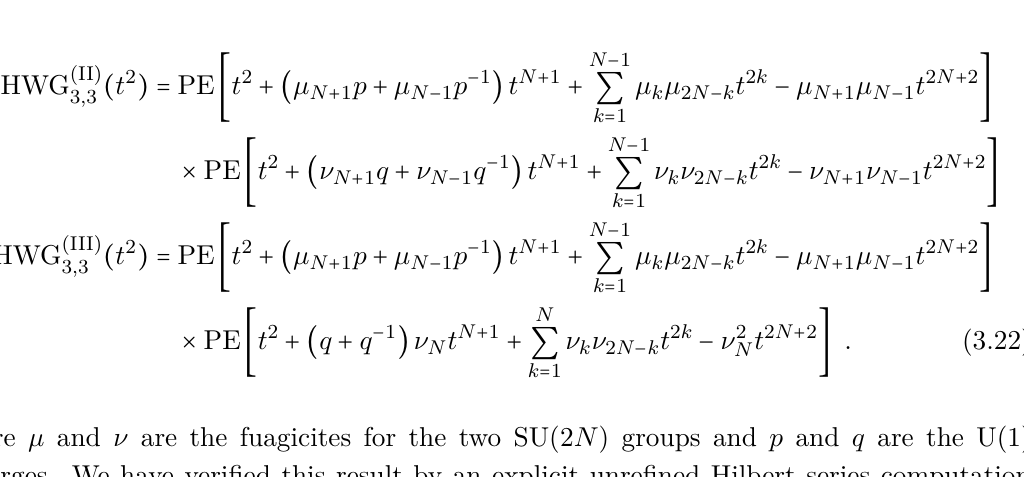
Figure 4. Brane webs for EQ 3 ′ , 3 ′ (left) and EQ 3 ′